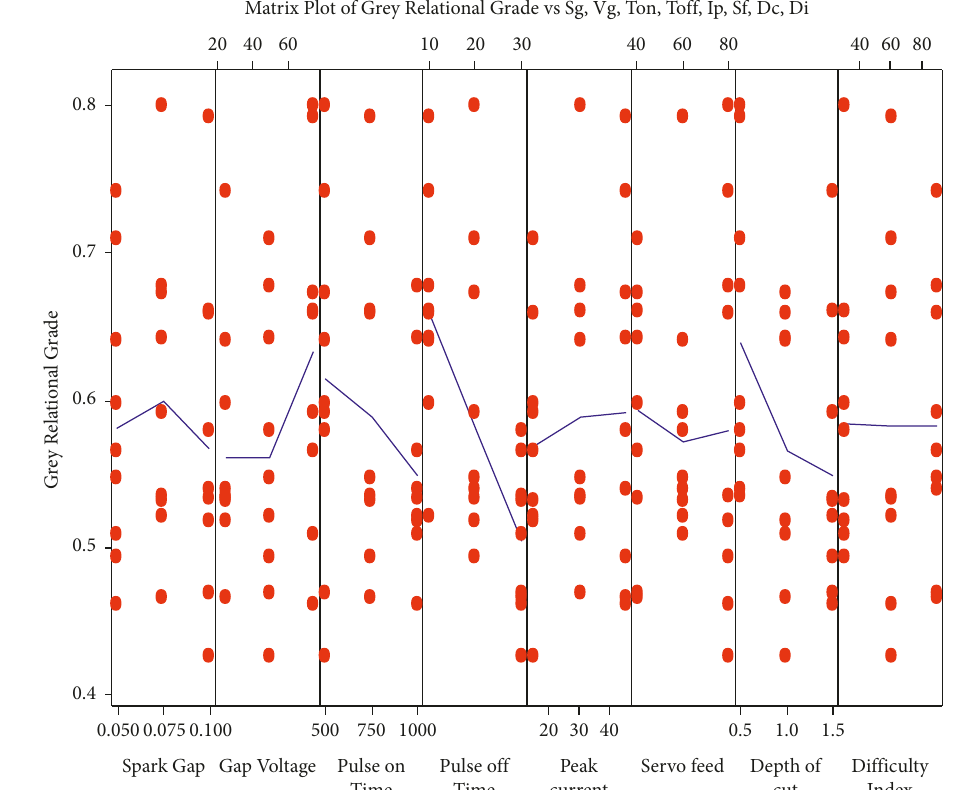
Figure 10: Matrix plot for overall grey relational grade